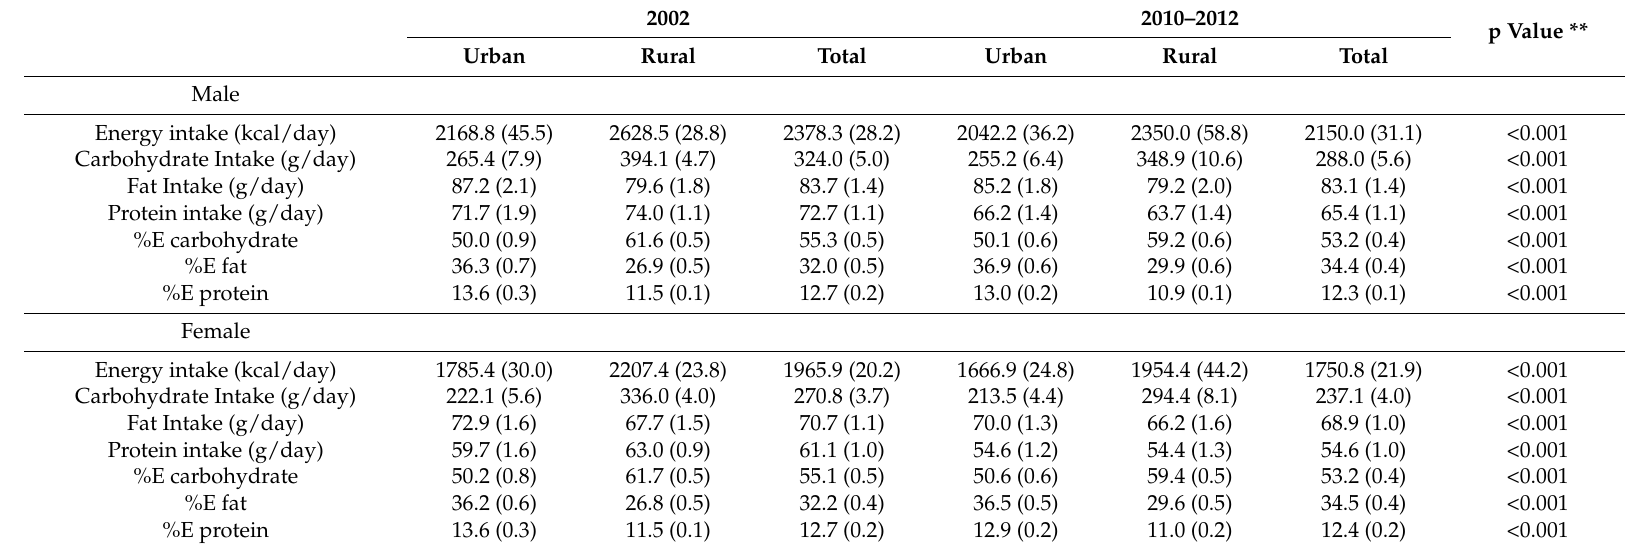
Table 4. Energy, macronutrients, and percentage of energy in participants between the two surveys